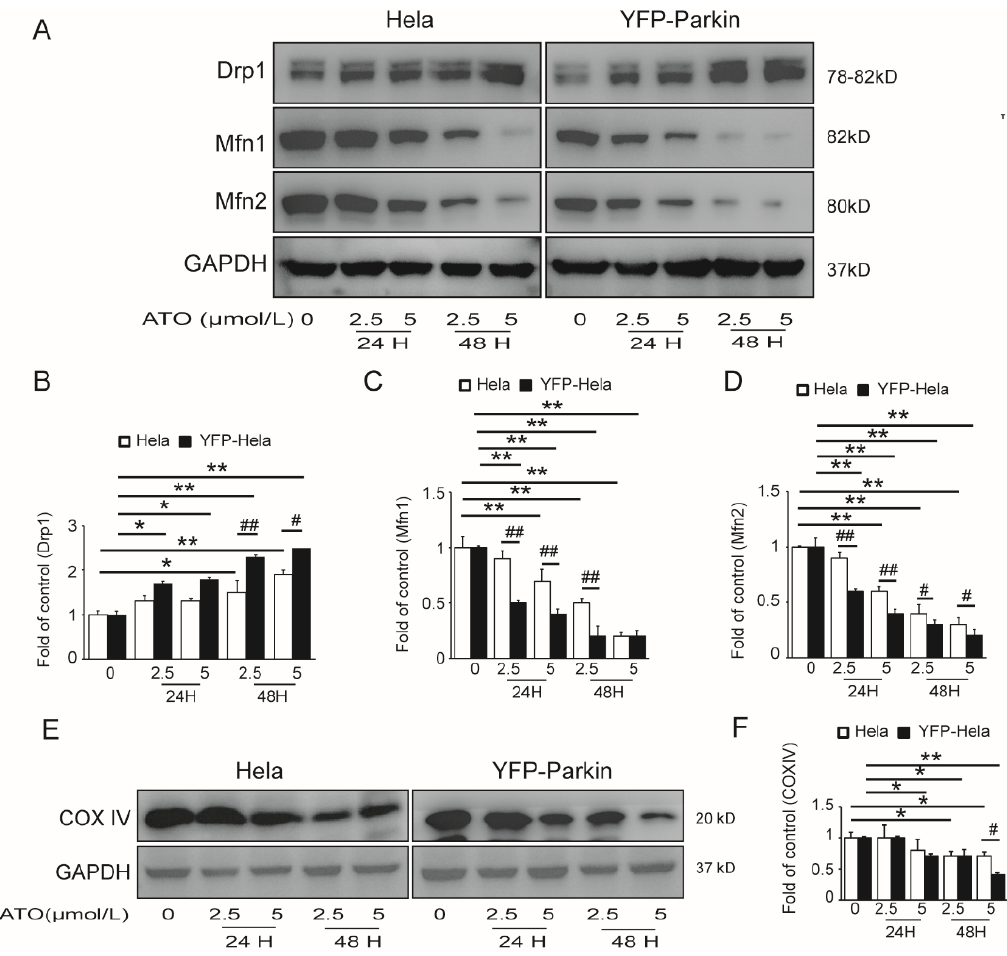
Figure 3. Effects of ATO exposure on mitochondrial dynamics in HeLa cells. ( A ) Western blot analysis of Drp1, Mfn1 and Mfn2 expression. ( B – D ) Quantification of A. ( E ) Western blot analysis of COX IV expression in the indicated cells. ( F ) Quantification of E. The histograms represent the mean ± SD of triplicate experiments. * p < 0.05 vs. 0 µmol/L group, ** p < 0.01 vs. 0 µmol/L group, # p <0.05 vs. without Parkin group, ## p <0.01 vs. without Parkin group; GAPDH served as an internal control.